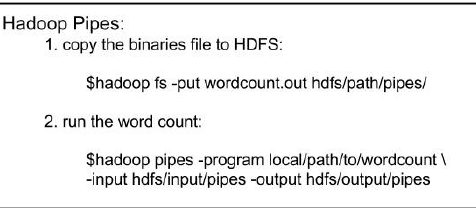
Fig. 10. Hadoop Pipes Command Line